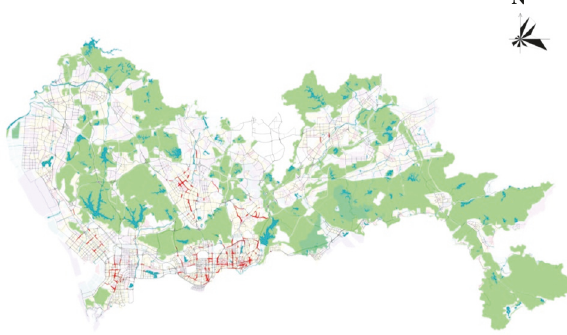
Figure 10: 2015 Shenzhen recurrent congested road